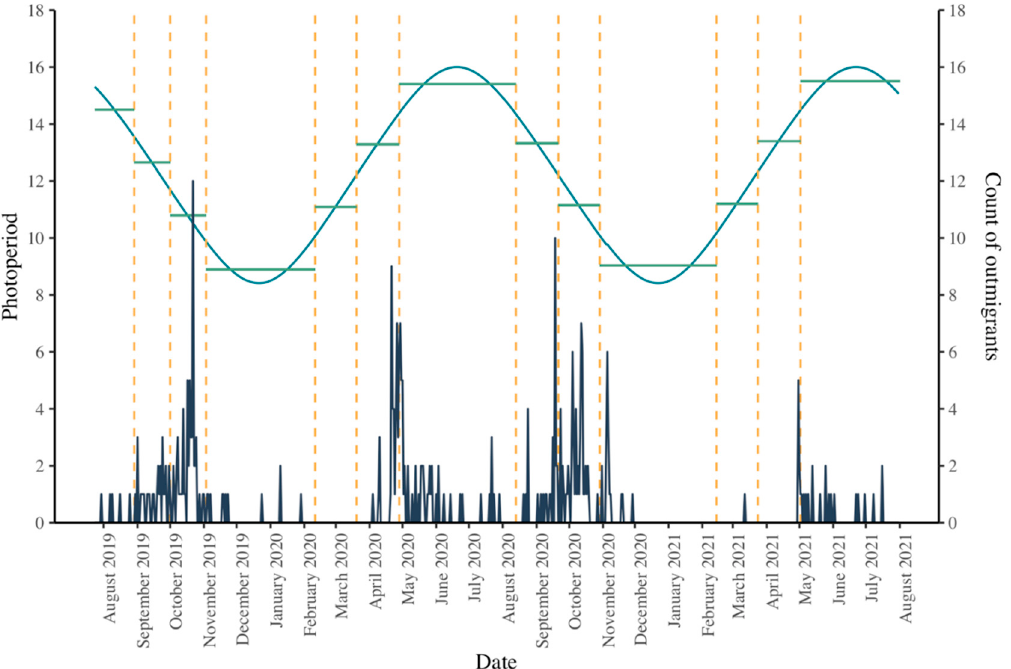
Figure 8. Time series from Graves Creek, Montana, from 25 July 2019 through 1 August 2021, with the light blue line delineating time series of the photoperiod (hours) and the dark blue line delineating time series of bull trout out-migrating by day. Dotted yellow lines delineate changepoints, and horizontal green lines represent the mean for each segment between the changepoints.